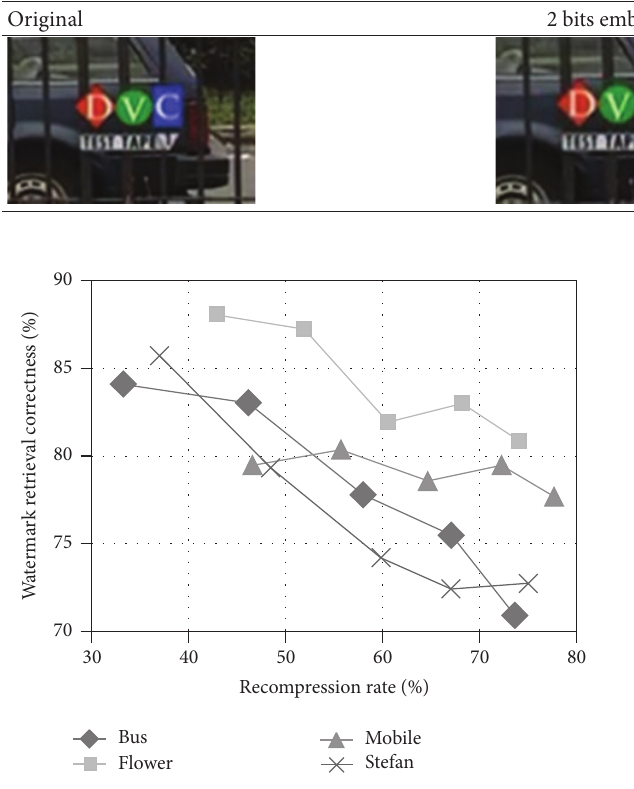
Figure 19: Watermark correctness rate after lossy compression with different QP values.